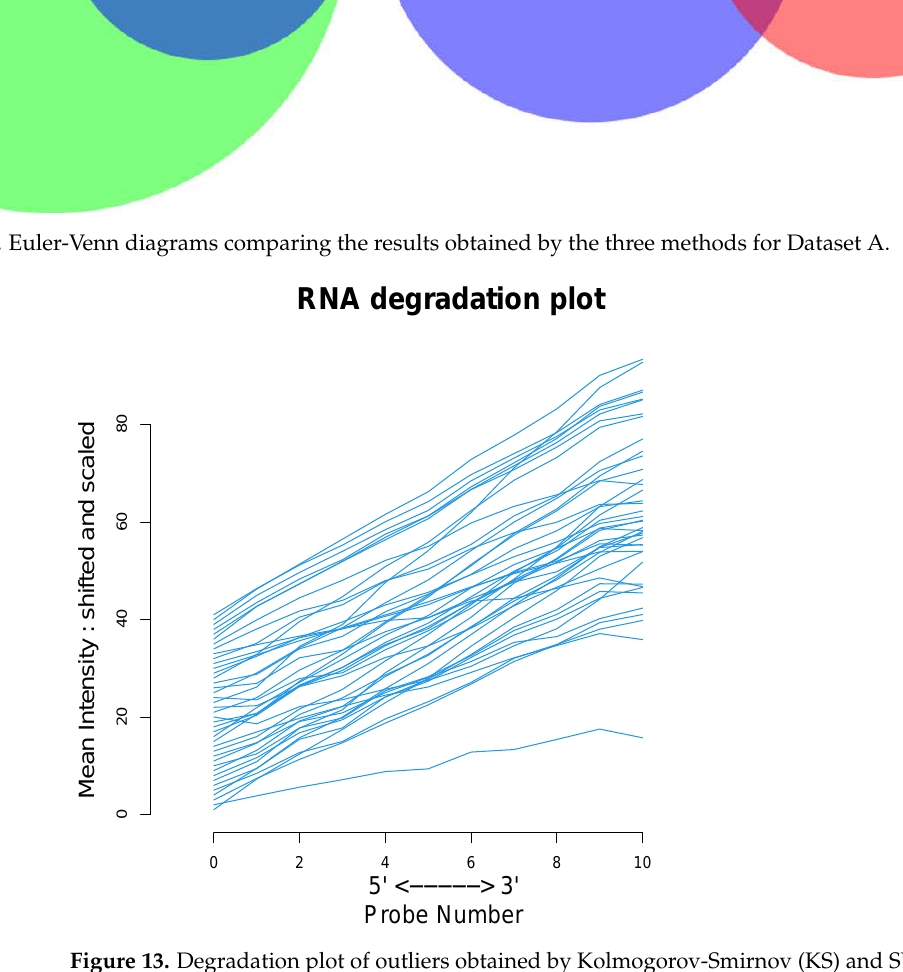
Figure 13. Degradation plot of outliers obtained by Kolmogorov-Smirnov (KS) and SUM techniques applied on Dataset